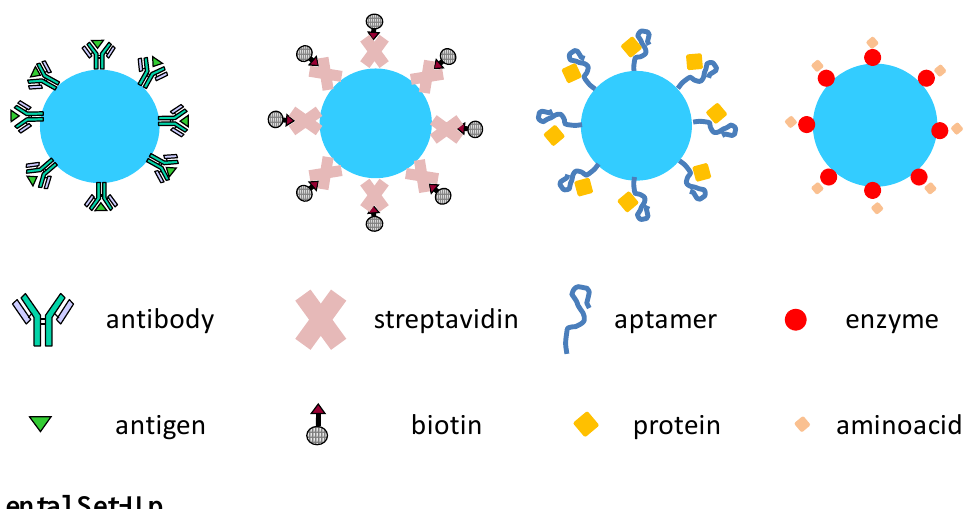
Figure 5 . Top: Schematic representation of a WGM biosensor, resulting from the union of a WGM resonator and a sensing layer. Middle row: main ligands or receptors (antibodies, streptavidin, aptamers, enzymes). Bottom: main analytes (antigens, biotin(ylated) proteins, aminoacids).